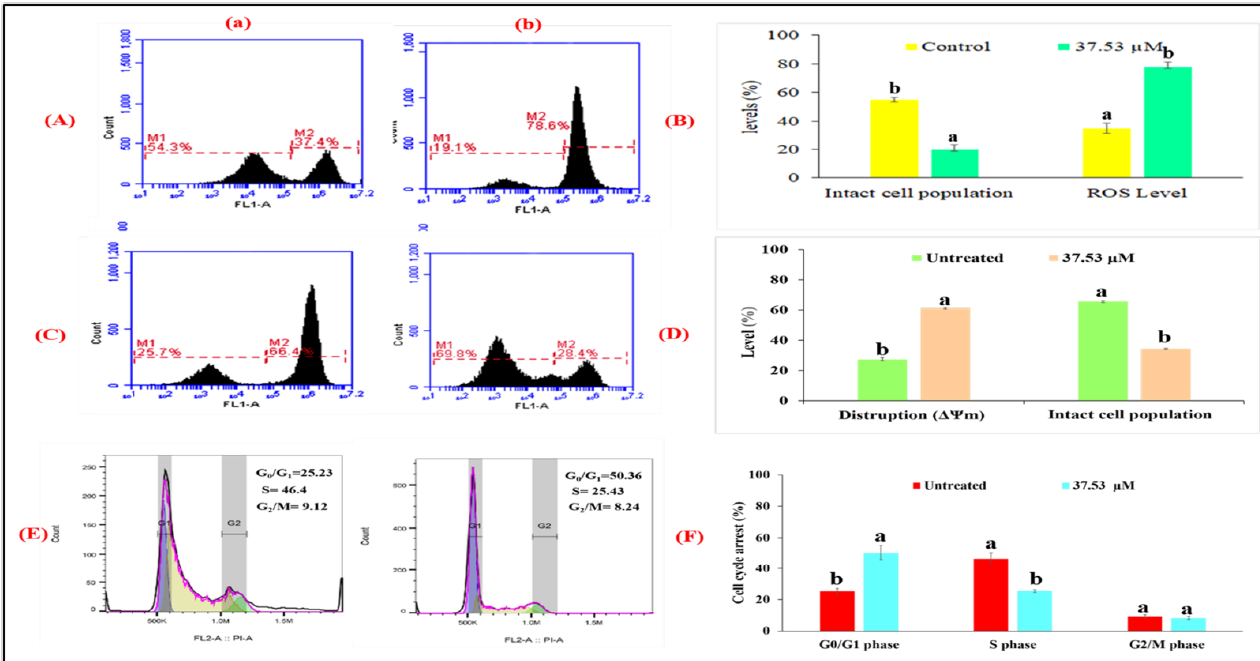
Figure 12. ( A ) The generation of intracellular ROS in MG-63 detected by DCFH-DA staining (M1 represents an intact cell population, and M2 represents cells with the accumulation of intracellular ROS). ( B ) Histogram showing the generation of intracellular ROS in MG-63 cells (24 h) exposed to BDCe fraction from O. bracteata . ( C ) The disruption of mitochondrial membrane potential (ΔΨm) in Mg-63 cells detected by staining with Rhodamine 123 (M1 represents cells with the disruption of ΔΨm and M2 represents the intact cells.). ( D ) Histogram showing disruption of mitochondrial membrane potential (Δ Ψ m) in MG-63 cells (24 h) exposed to BDCe fraction from O. bracteata . ( E ) The treatment of the BDCe fraction from O. bracteata (24 h) induced cell cycle arrest at the G 0 /G 1 phase in MG-63 cells detected by a cell-cycle-analysis kit. ( F ) Histogram showing different phases of G 0 /G 1 , S, G 2 /M in MG-63 cells using a flow cytometer. ( a ) Untreated MG-63 cells, ( b ) MG-63 cells treated with BDCe fraction (37.53 µM) for 24 h. Data labels with different letters represent significant difference among them at ( p ≤ 0.05).